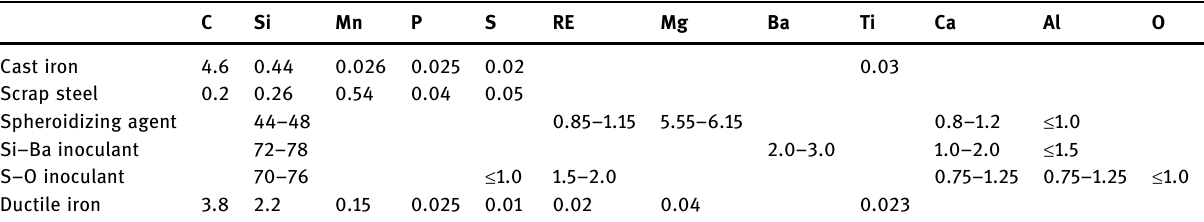
Table 1: Chemical compositions of raw materials and ductile iron for the experiment ( wt% )